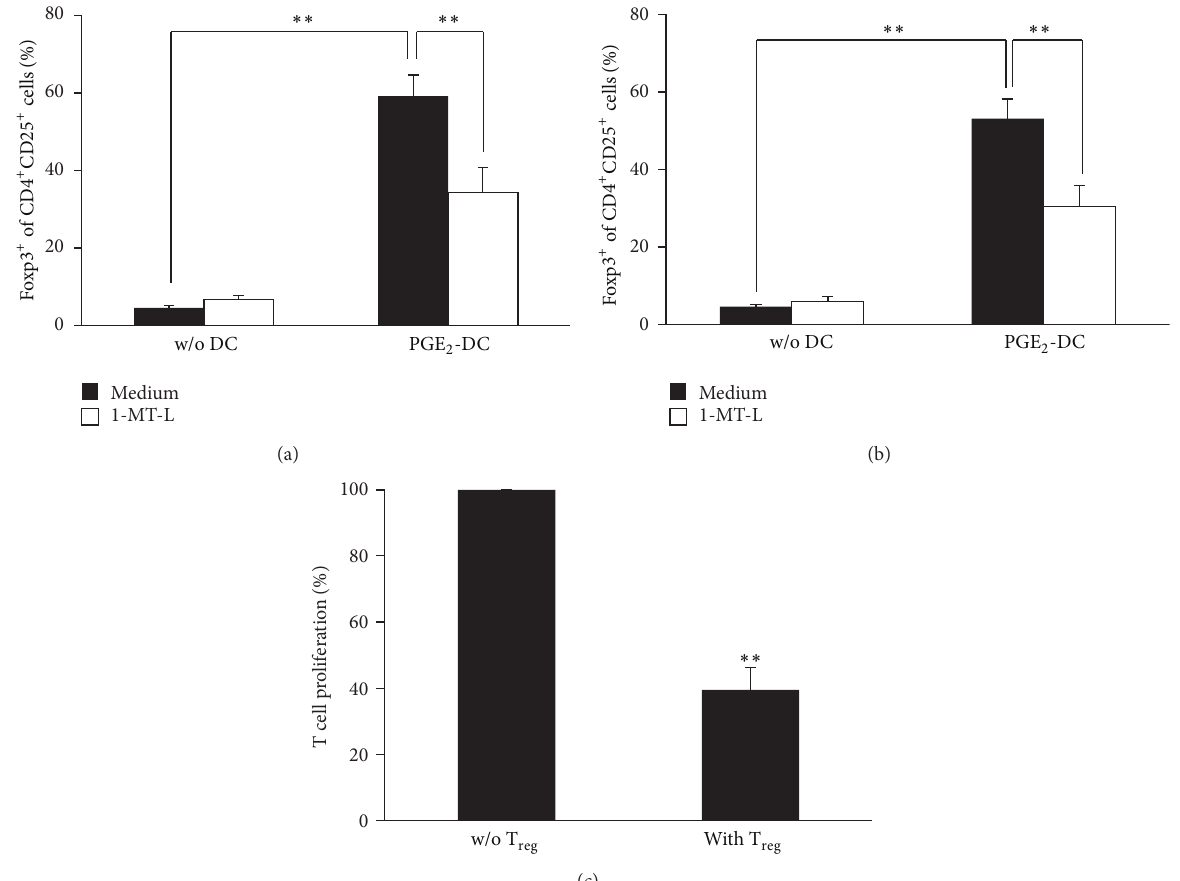
Figure 3: IDO1 expression induced T . Expression of Foxp3 on (a) allogeneic and (b) autologous CD4 + CD25 + T after 5-day culture with regs or without high IDO-expressing DCs that is matured with IL-1 𝛽 /IL-6/TNF- 𝛼 /PGE 2 (complete cocktail), in presence or in absence of the IDO1-specific inhibitor 1-MT-L. The results showed in (a)-(b) are expressed as the mean ± SEM of 5 different experiments. ∗∗ 𝑃 < 0.01 . (c) CD3 + T cells were stimulated by allogeneic immature DCs in the presence and absence of CD4 + CD25 + T cells. CD4 + CD25 + T cells were purified after 5 days of culture in presence of high IDO-expressing DCs (i.e., matured with PGE 2 ). The results are expressed as percentage of ) as 100%. The results are expressed as CD3 + T cell proliferation with the proliferation observed in absence of CD4 + CD25 + T cells (w/o T regs the mean ± SEM of 3 different experiments. ∗∗ 𝑃 < 0.01 versus w/o T regs